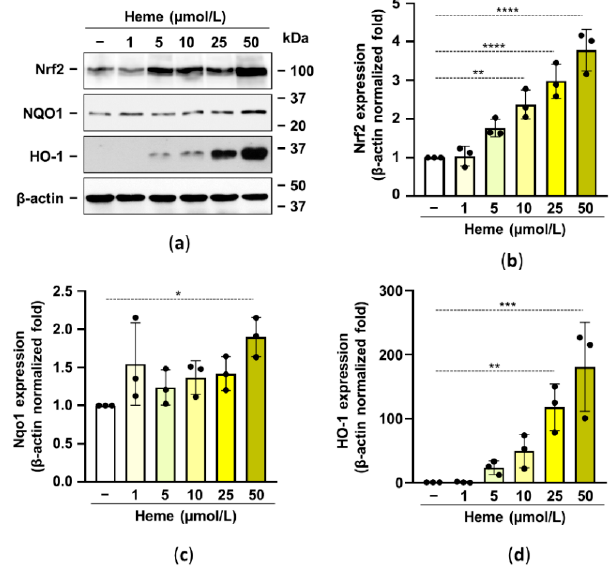
Figure 2. Heme induces the Nrf2/HO-1 axis in HuLECs. ( a – d ) Confluent HuLECs (passage 5–8) were treated with heme (0–50 µmol/L). Protein expressions of Nrf2, NQO1, HO-1, and β -actin were determined from whole-cell lysates (12 h). ( a ) Representative Western blots out of three. ( b – d ) β - actin-normalized relative expression of Nrf2, NQO1, and HO-1. Bars represent mean ± SD. Ordinary one-way ANOVA followed by Dunett’s multiple comparison test was used to obtain p values. * p < 0.05, ** p < 0.01, *** p < 0.005, **** p < 0.001.